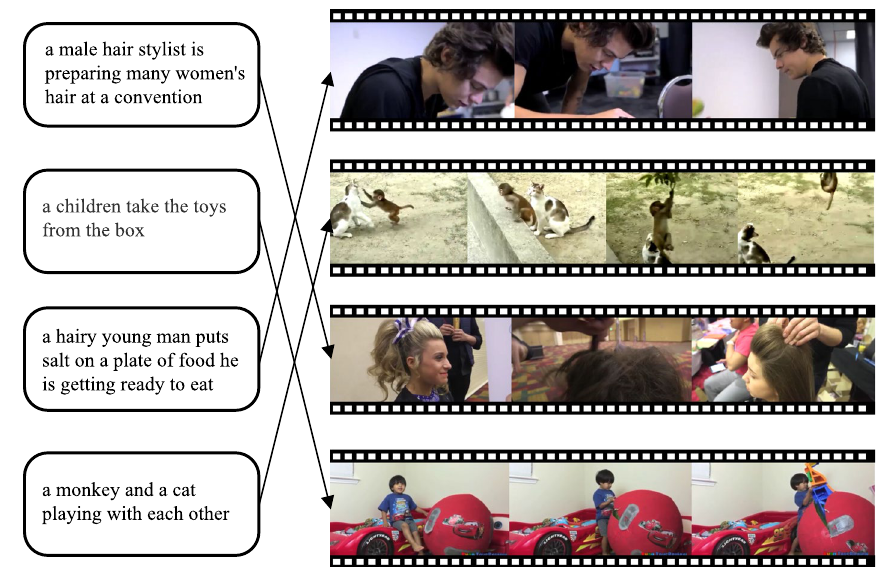
Fig. 1 Illustration of text-to-video retrieval: given a text query, retrieve the corresponding video from the